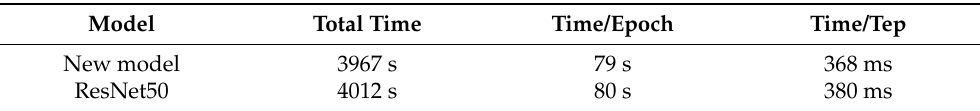
Table 8. Computational cost of the ResNet50 model and proposed model for the 100 sports image classification